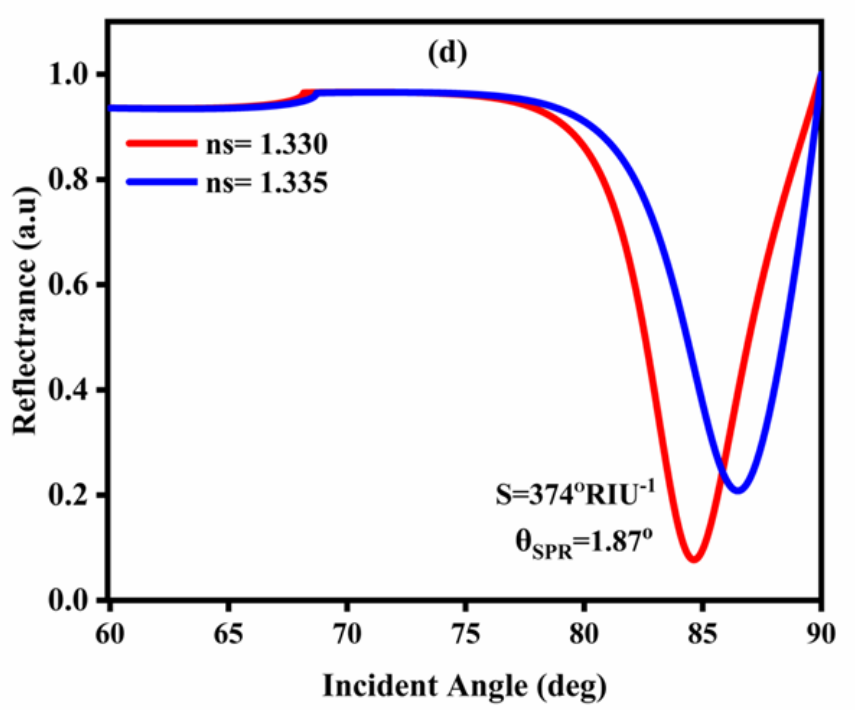
Figure 2. SPR reflectance curves: ( a ) design 1; ( b ) design 2; ( c ) design 3; ( d ) design 4. Table 3. Comparative study of different proposed SPR sensors at a wavelength of 633 nm and Δn = 0.005.